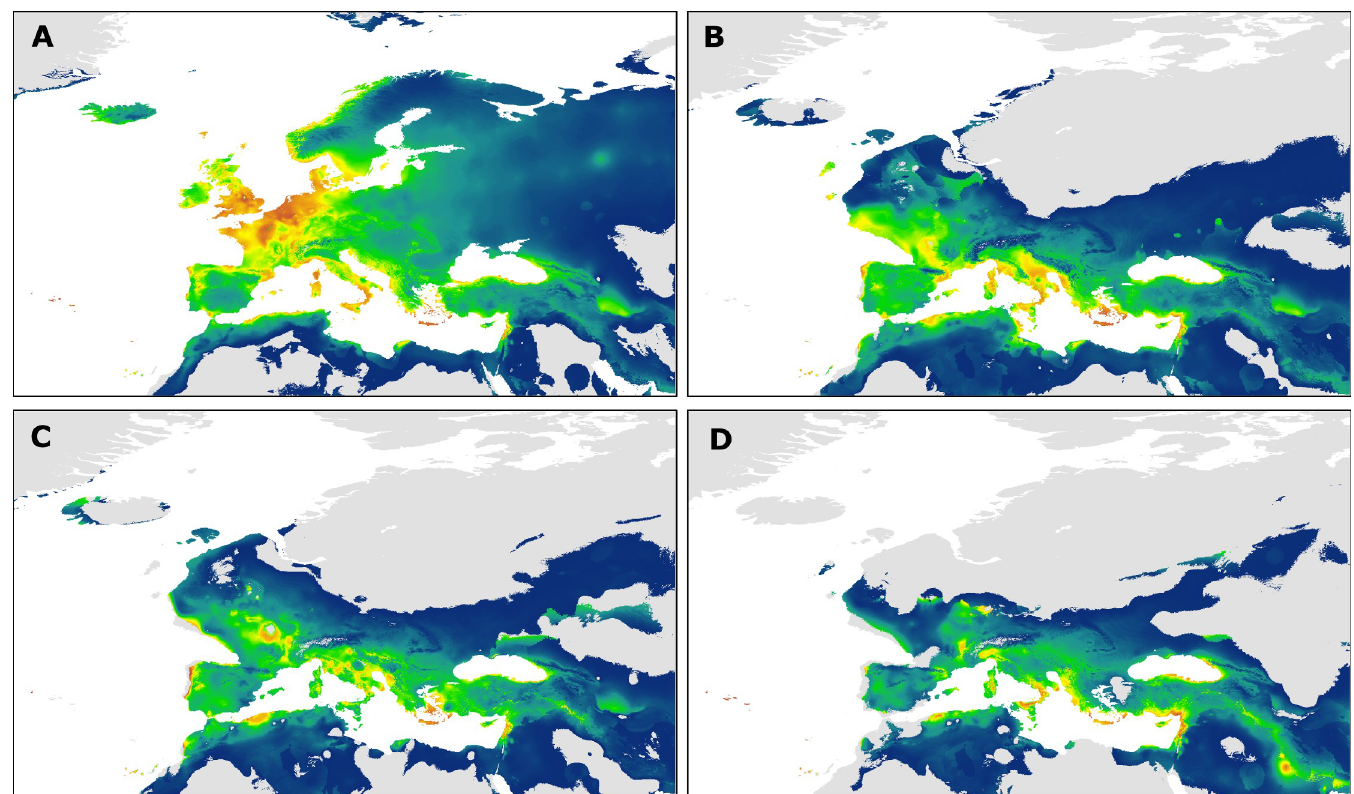
Fig 6. Results of species distribution modelling for Western Palearctic Nannus troglodytes . Current potential distribution as derived from Maxent (A). Projection onto climatic conditions of the Last Glacial Maximum as derived from the global circulation models MPI-ESM-P (B), CCSM3 (C), and MIROC-ESM (D). Suitability ranges from moderate (dark blue) to high (red).